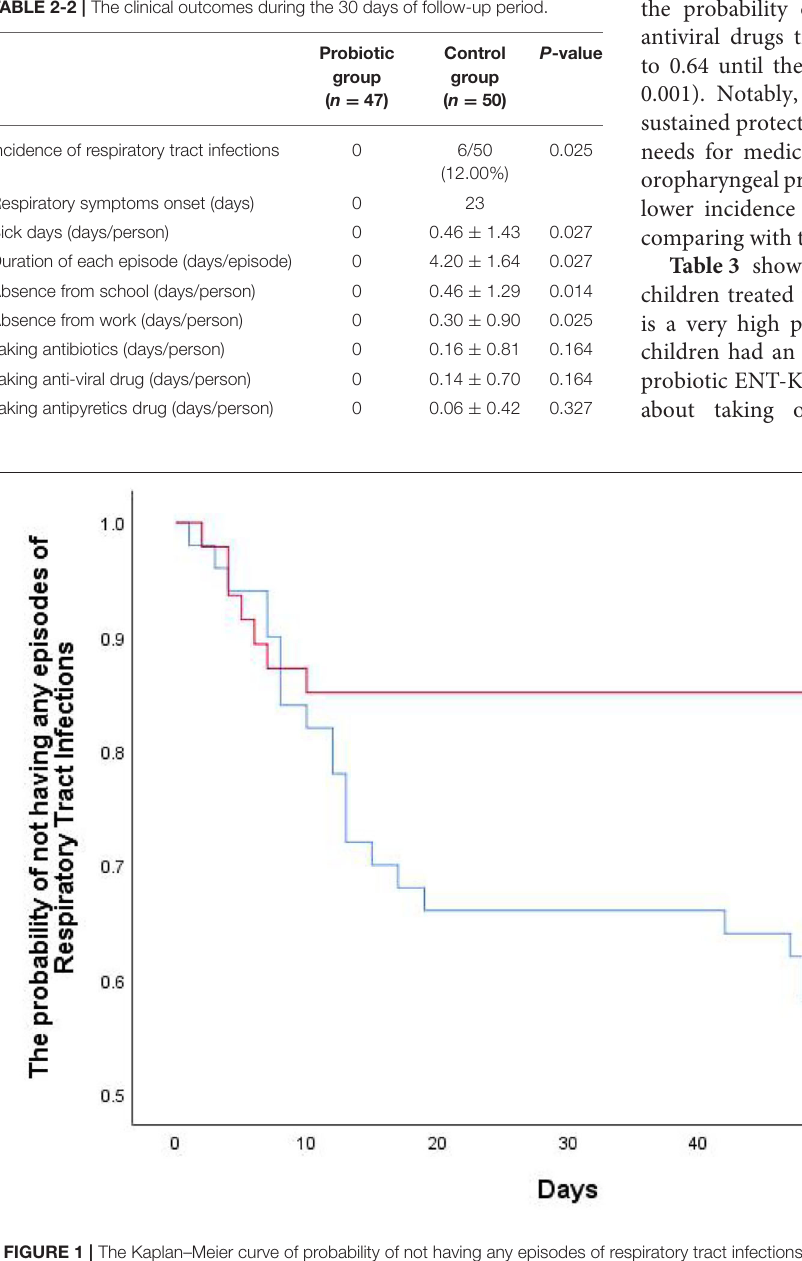
Frontiers in Nutrition |